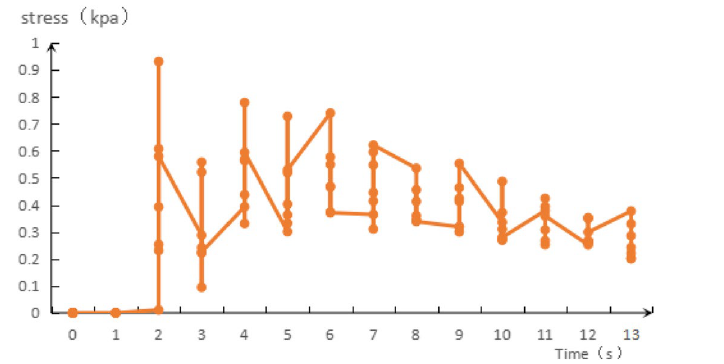
Figure 12. Stress changes at different